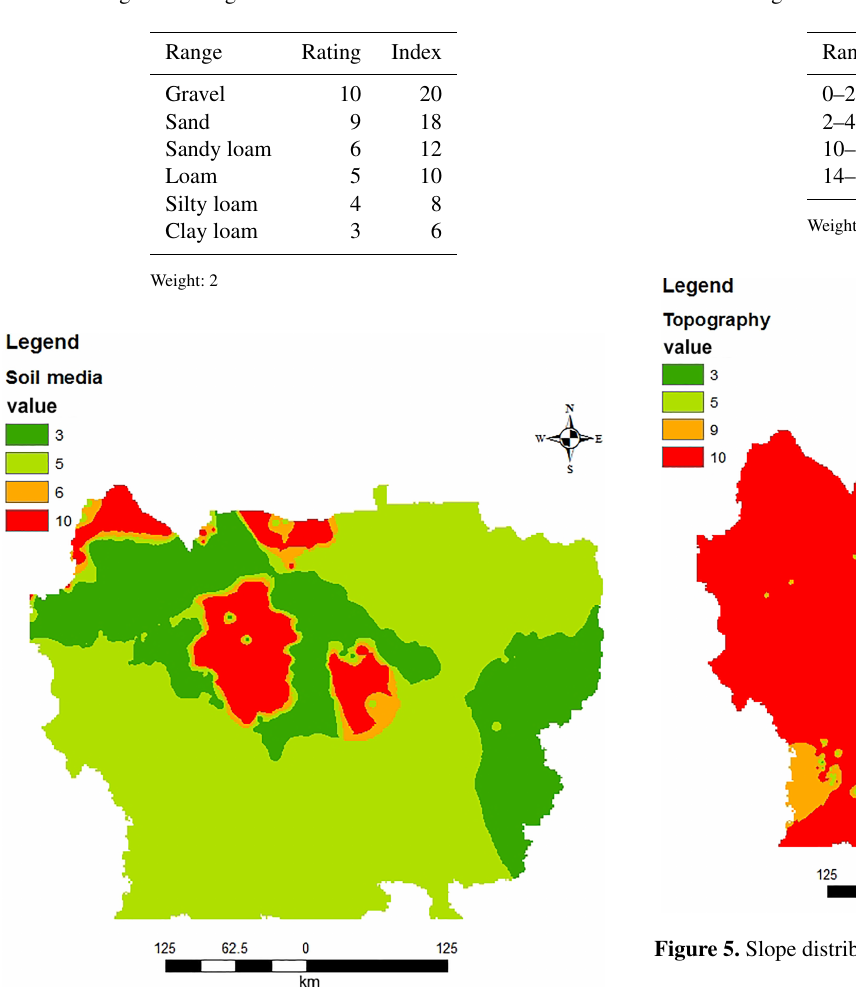
Figure 4. Soil type distribution map.